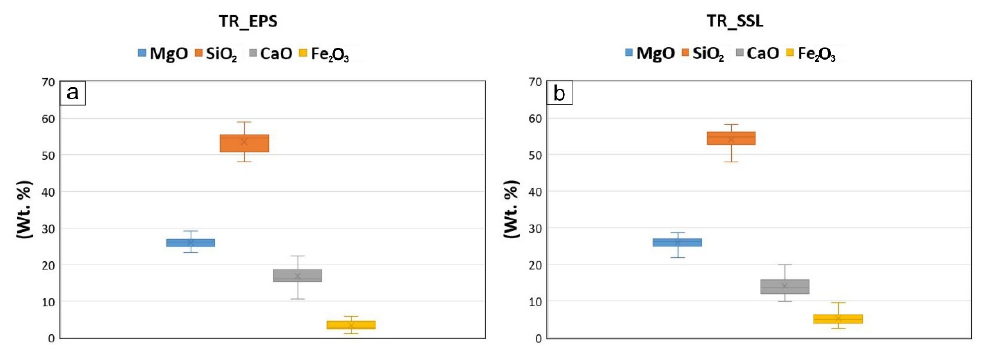
Figure 2. Box plots illustrating statistical parameters for major elements in: ( a ) tremolite asbestos from Episcopia (TR_EPS); and ( b ) tremolite asbestos from San Severino Lucano village (TR_SSL). Statistical parameters are based on 60 spot analyses. The range in contents is represented by the vertical lines, the median value is shown by the horizontal line inside the box, the cross indicates the mean values. Table 1. Average values of major and minor element amounts (wt%) in the examined tremolite obtained by µ -XRF. TR_EPS = tremolite asbestos from Episcopia; TR_SSL = tremolite asbestos from San Severino